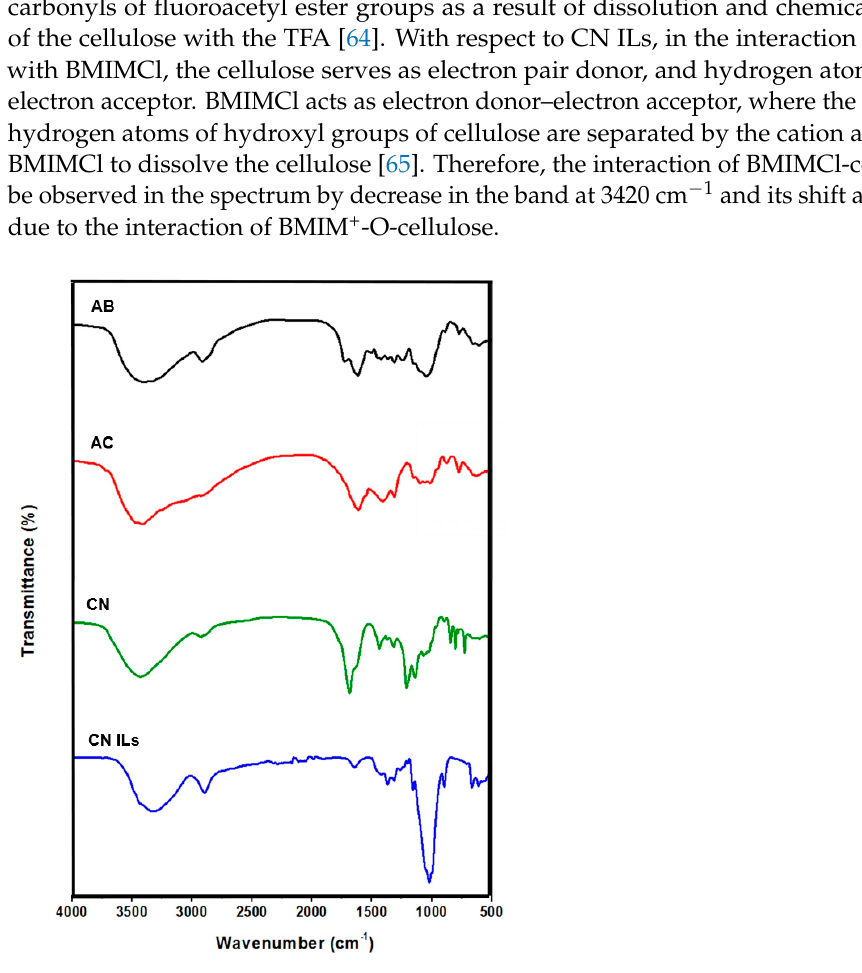
Figure 4. ATR-FTIR spectra of agave bagasse (AB), agave cellulose (AC), cellulose nanofibers with organic solvents (CN), and cellulose nanofibers with ionic liquids (CN